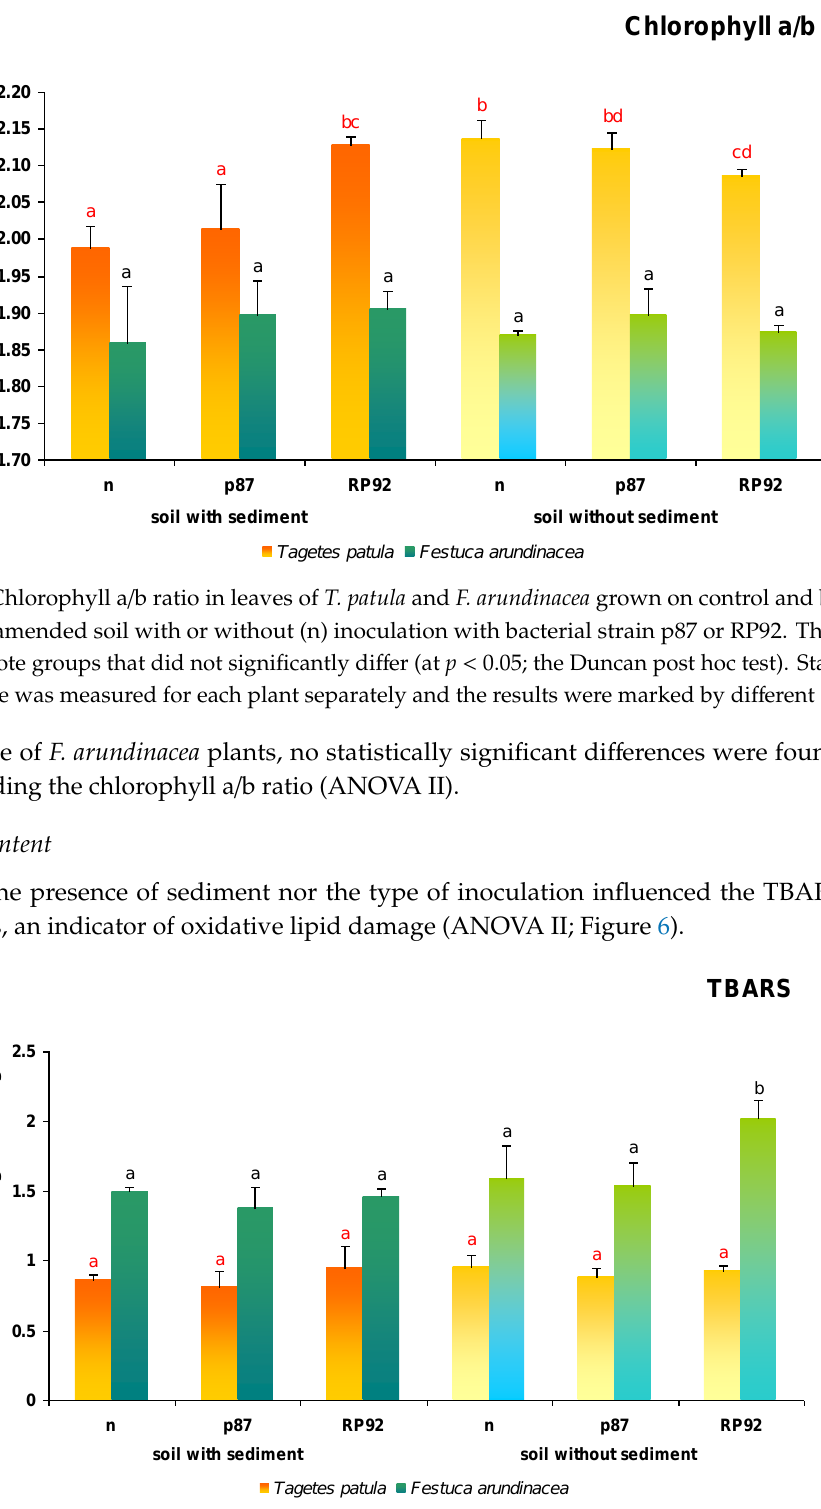
Figure 6. 2-thiobarbituric acid reactive substances (TBARS) content in leaves of T. patula and F. arundinacea grown on control and bottom sediments amended soil with or without (n) inoculation with bacterial strain p87 or RP92. The same letters denote groups that did not significantly differ (at p < 0.05; the Duncan post hoc test). Statistical significance was measured for each plant separately and the results were marked by different colors.